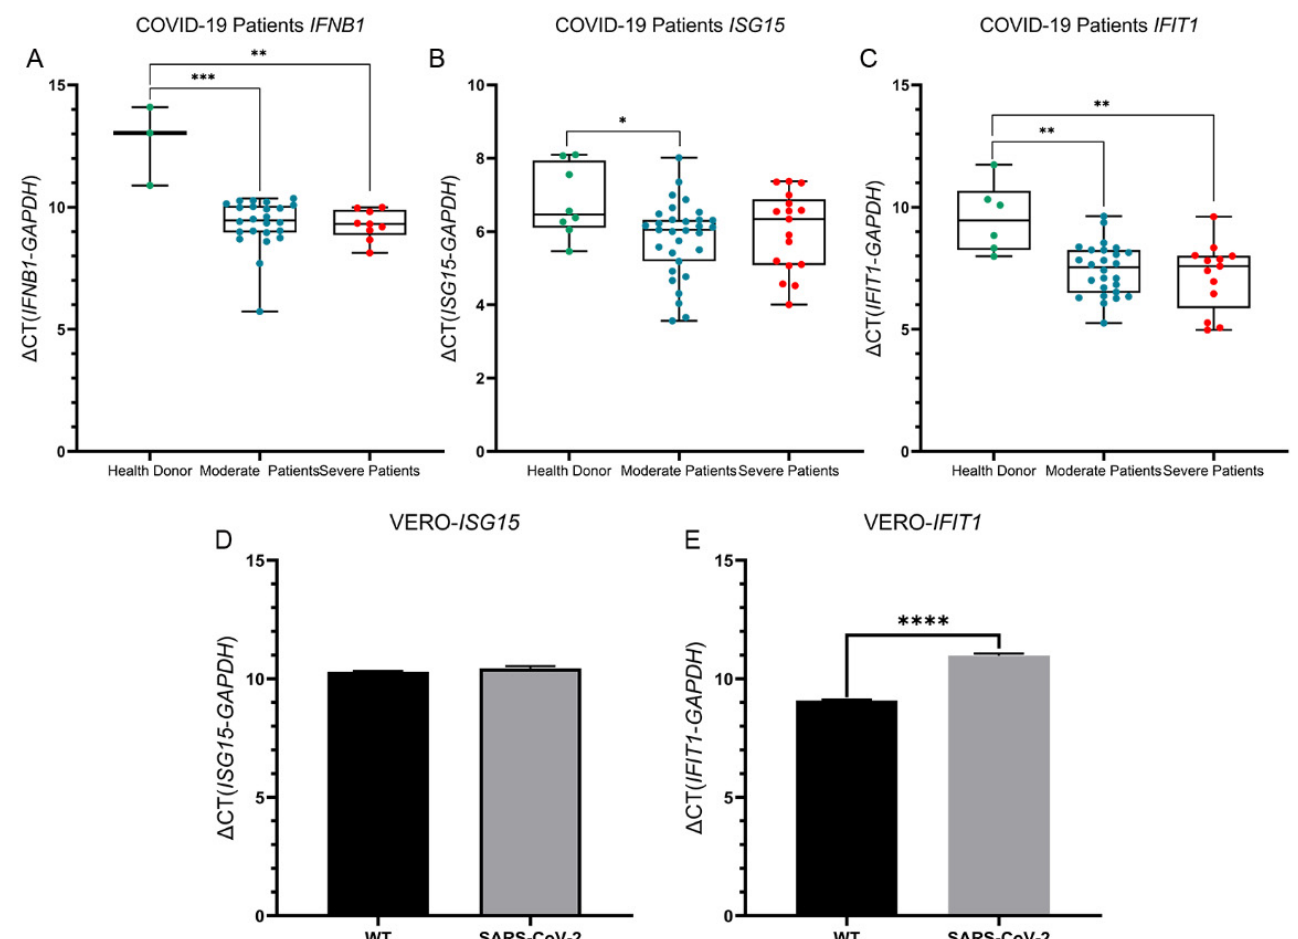
Figure 2. Comparison of interferon-related genes in COVID-19 patients and VERO cells infected with SARS-CoV-2. ( A – C ) The expression of IFNB1 , ISG15 , and IFIT1 in health donor (green dot), moderate (blue dot) and severe COVID-19 patients (red dot). ( D – E ) The expression of ISG15 and IFIT1 in VERO cells control (black column) and VERO cell infected with SARS-CoV-2 (grey column). Each point represents three repeats. The box plots show the medians (middle line) and first and third quartiles (boxes), and the whiskers show the minimum and maximum. Mann–Whitney test p values are depicted in the plots. Mann-Whitney test P-values are depicted in the plots. * p < 0.05, ** p < 0.01, *** p < 0.001, **** p < 0.0001.